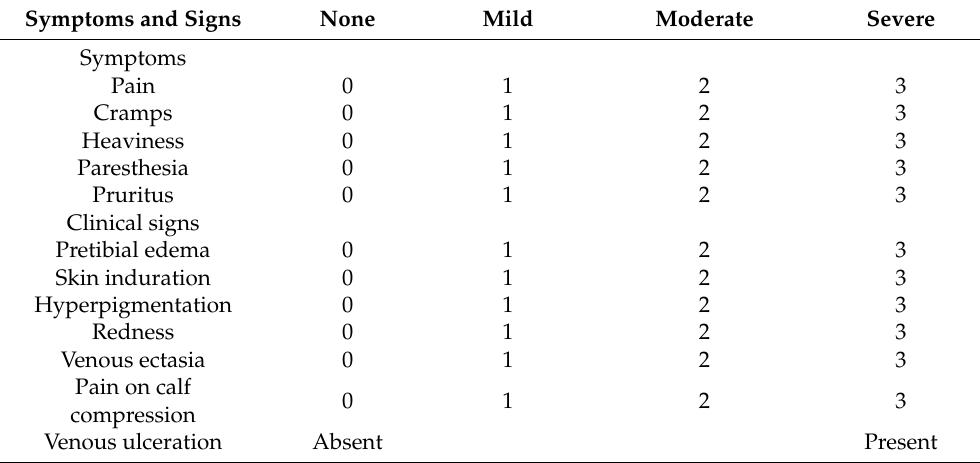
Table A1. Villalta